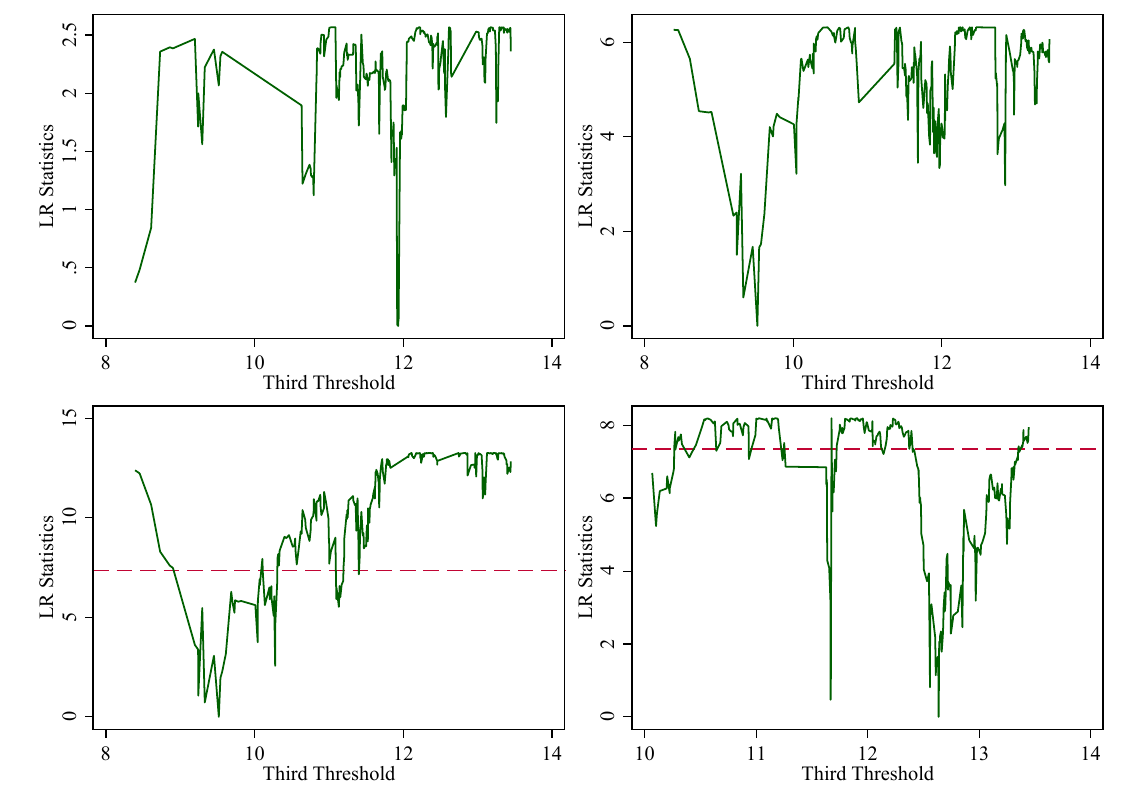
Figure 8. LR test results of segmented industries. Note: These graphs were created by the author